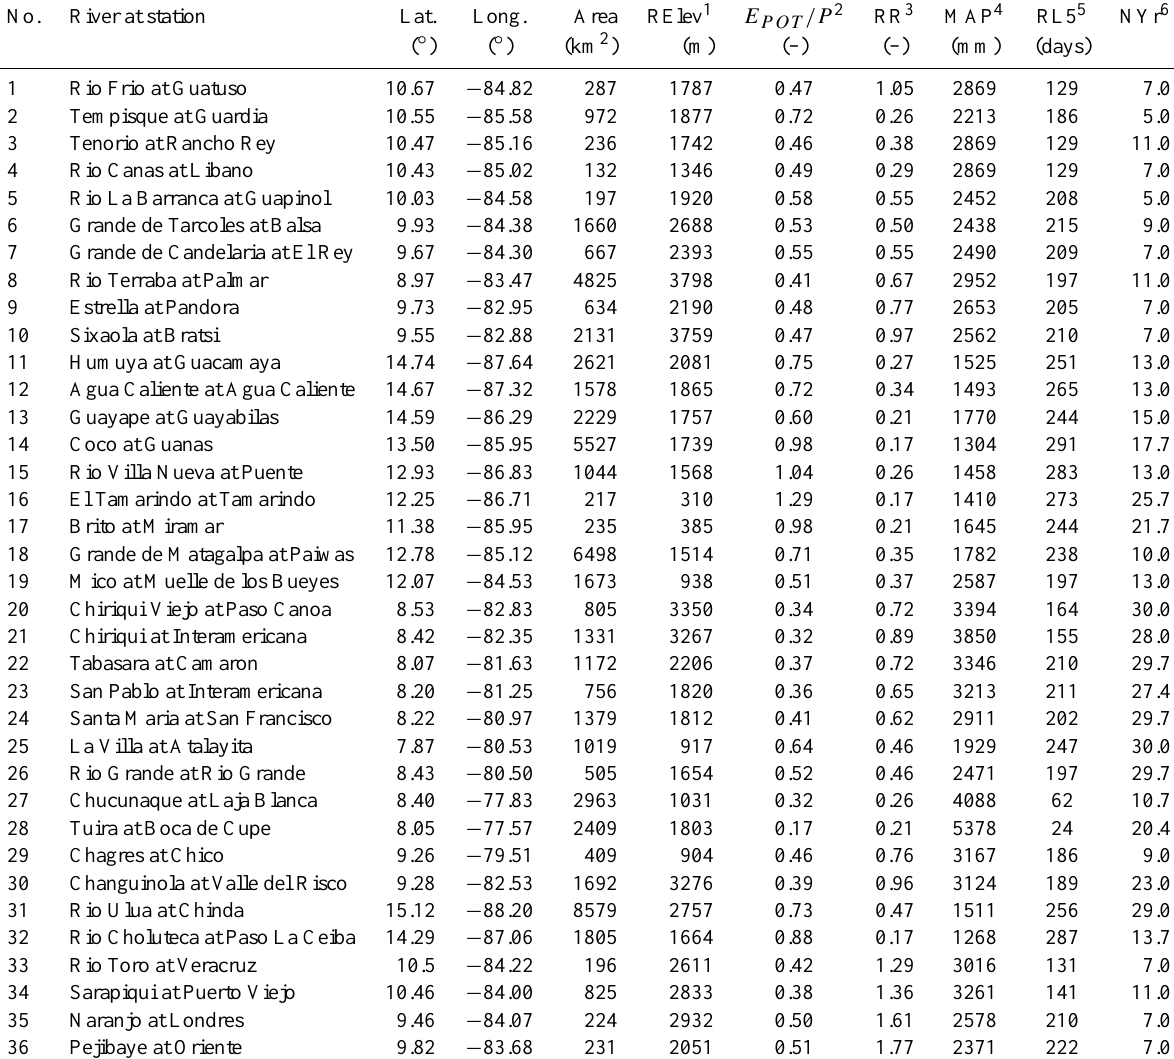
Table A1. Discharge stations and basin characteristics, indices calculated for 1965–1994 except for RR and E POT /P that were calculated for the period of discharge record (i.e. the same as in the Budyko plot, Fig. 4).